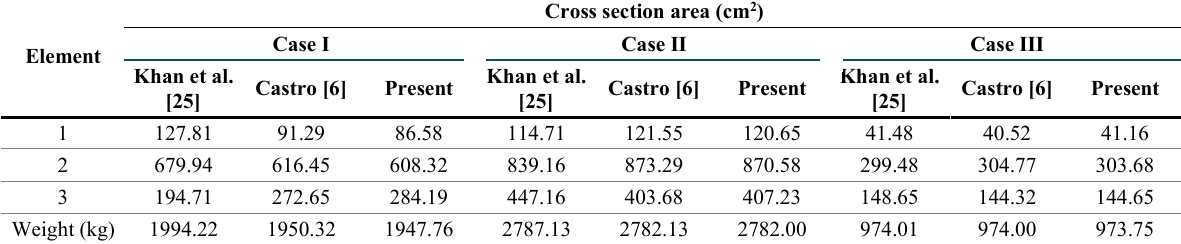
Table 4. Comparison of results.